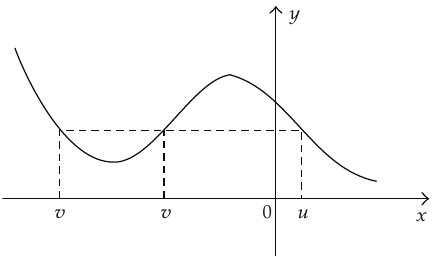
Figure 1: The picture of y (cid:2) f (cid:3) x (cid:4) /g (cid:3) x (cid:4) in (cid:3) 2 (cid:4) .